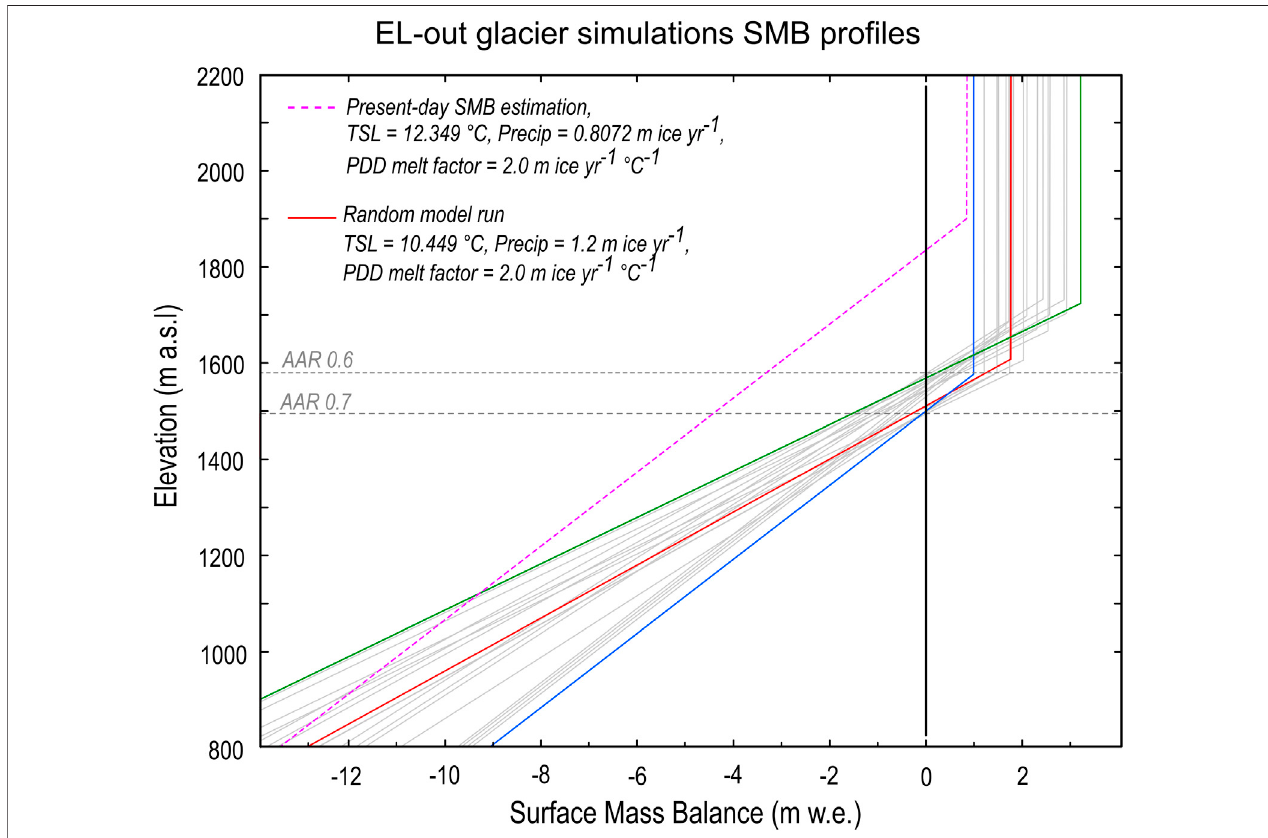
FIGURE4| Asample(n (cid:1) 20)ofSurfaceMassBalance(SMB)pro fi les(greyandcolouredlines)oftheEL-outice- fl owmodelsimulationsusingapositivedegree-day SMB parameterisation. The pink dashed line is a surface mass balance pro fi le representative of our modern-day climate estimation, according to our assessment of modernlocalatmospherictemperature andprecipitation (section ModernClimate ),whenusinga PDD valueof5 mm w.e. d − 1 ° C − 1 .NotethattheSMBpro fi lesforEL-out model runsintersect the0SMBvalue(i.e.,theglacier equilibriumline)at elevationsassociatedwithAARvaluesofbetween0.6(greenline)and 0.7(blueline),which are used as threshold values to constrain our model